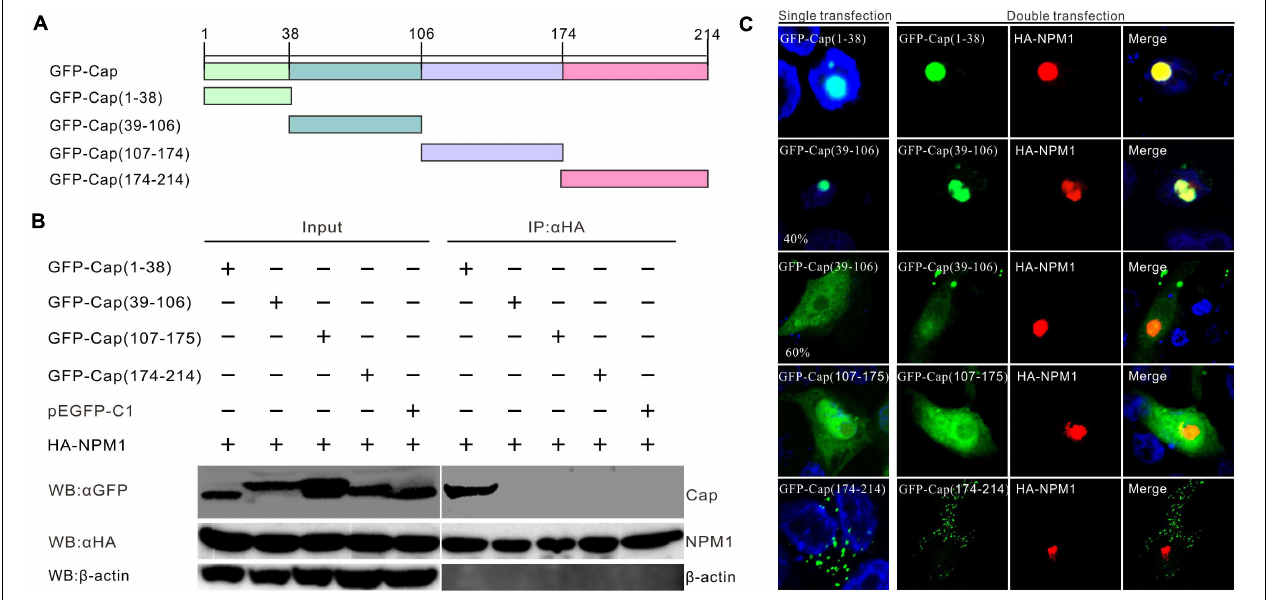
FIGURE 3 | Determination of the binding domains of PCV3 Cap with NPM1. (A) Engineering of truncated constructs of PCV3 Cap, GFP-Cap (1–38), GFP-Cap (39–106), GFP-Cap (107–174), and GFP-Cap (175–214). (B) The interaction regions between NPM1 and Cap confirmed by Co-IP in HEK293FT cells with co-transfection. At 24 h post-transfection, the cell lysates were immunoprecipitated with Pierce Anti-HA Magnetic Beads, western blot analysis using antibodies to HA, GFP, and β -actin. (C) Colocalization analysis. PK15 cells were co-transfected with GFP-Cap, truncation constructs of GFP-Cap, and HA-NPM1. The cells were incubated with the antibodies corresponding to the HA tag at 24 h post-transfection, and followed by the Alexa Fluor 568-conjugated secondary antibodies (red). Nuclei were stained with DAPI